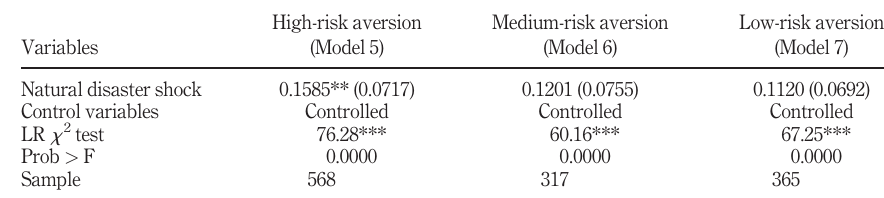
Table 5. In fl uencing path of natural disaster shock and risk